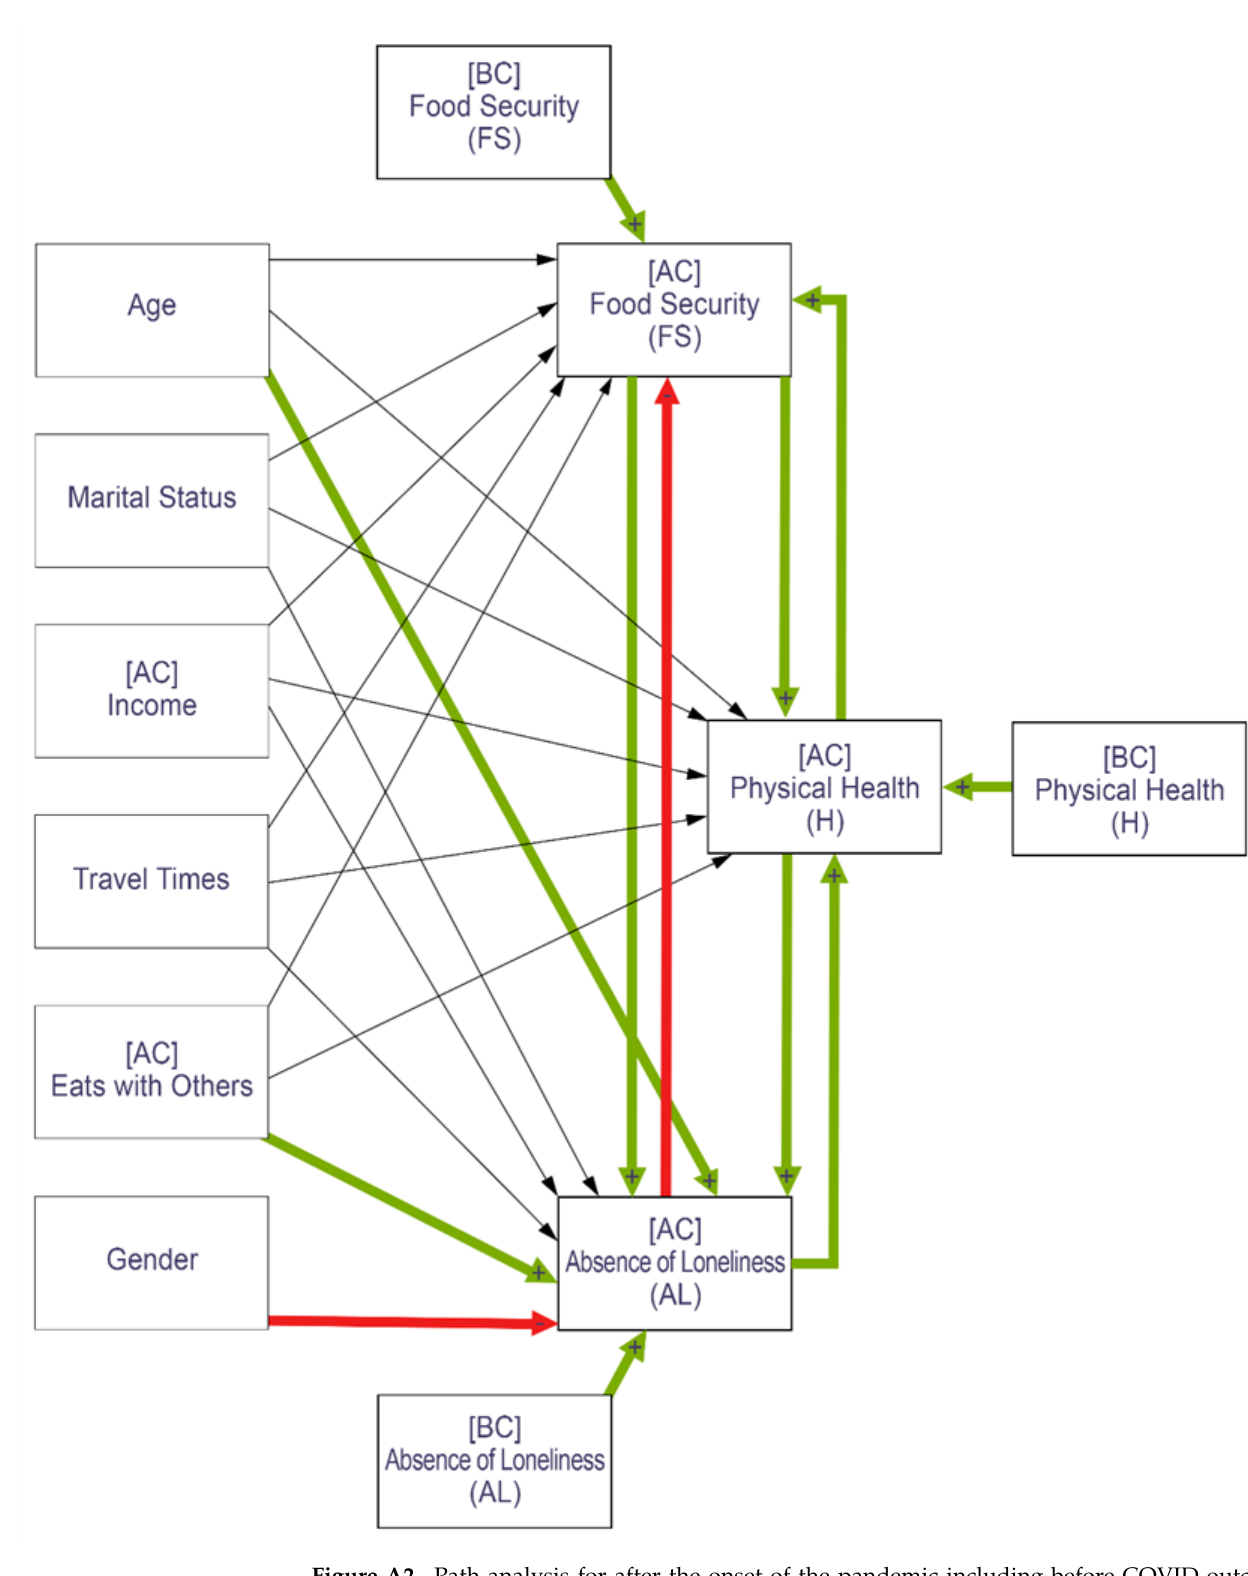
Figure A2. Path analysis for after the onset of the pandemic including before COVID outcome variables (FS, H, AL). Thin lines represent insignificance. Thick lines represent significance at α = 0.05. Green represents positive relationships and red negative relationships.